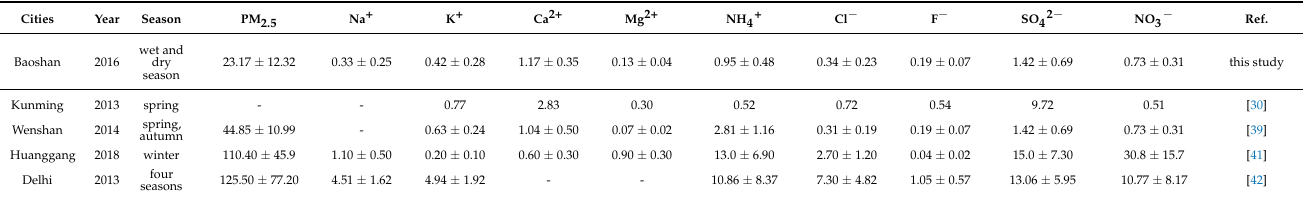
Table 2. Mean concentrations of WSIIs sampled in Baoshan in 2016 compared with data from other sites ( µ g/m 3